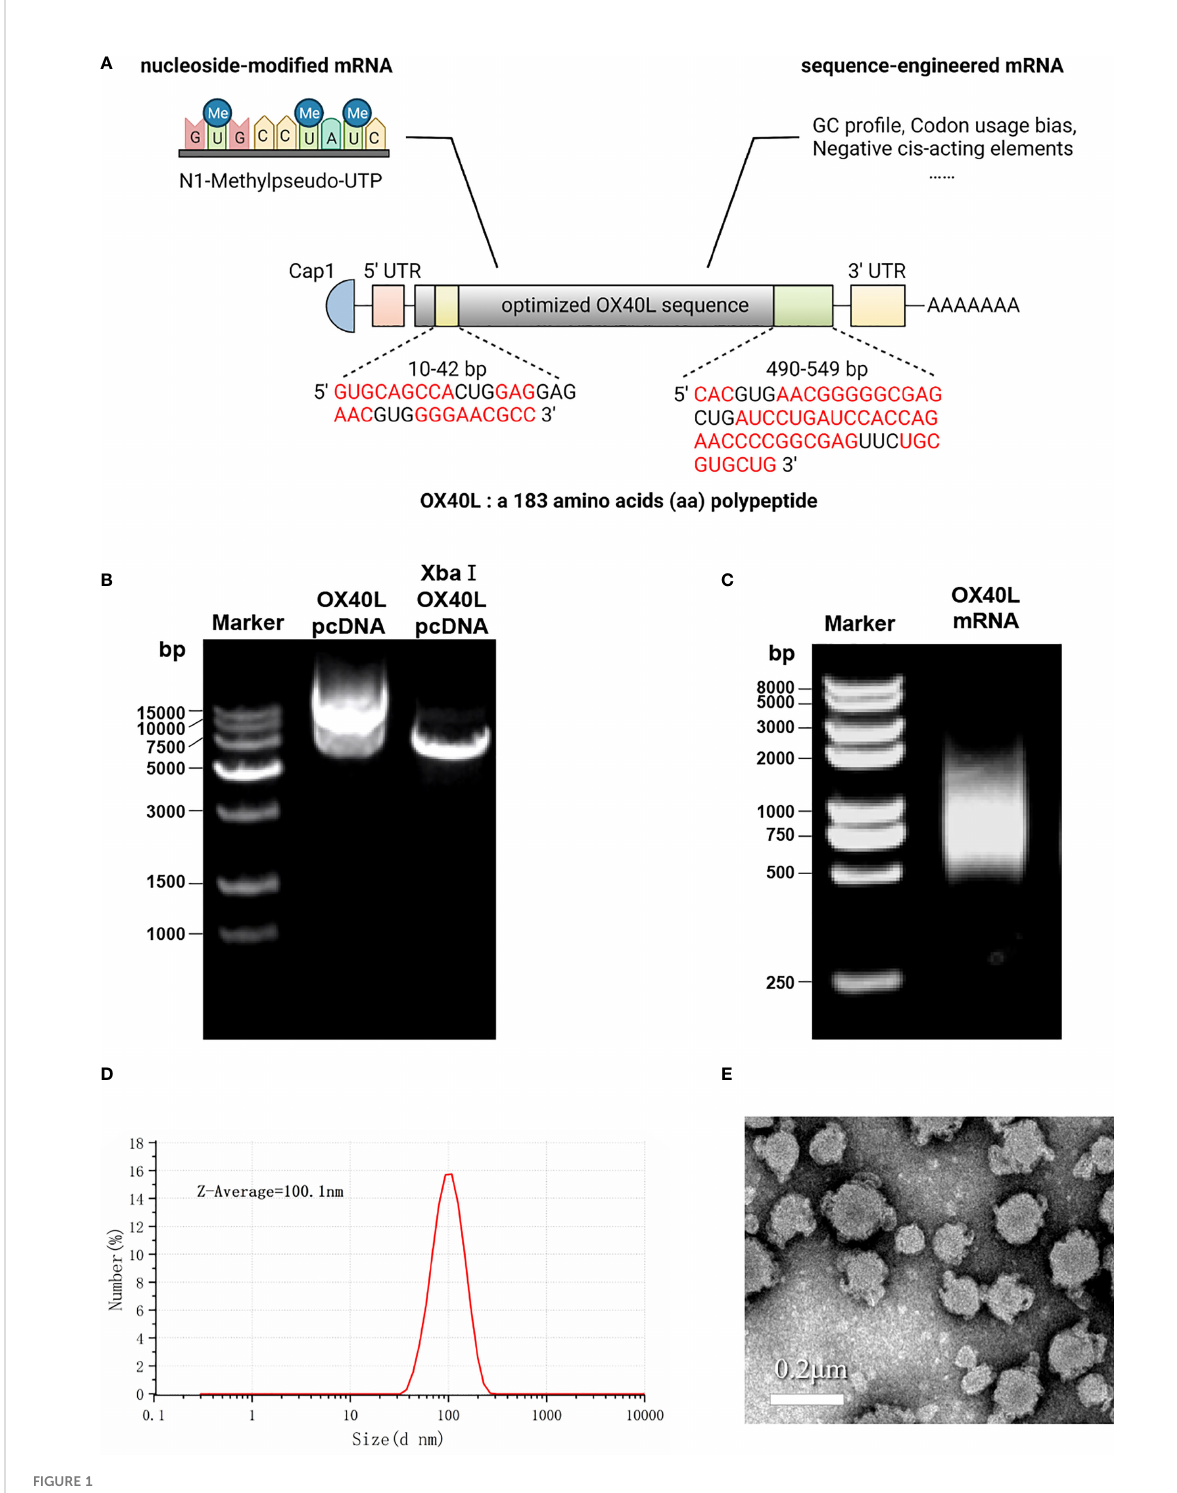
FIGURE 1 Optimization and characterization of encapsulated OX40L mRNA. (A) Structure of the optimized mRNA. Codons in red are optimized. (B) Identi fi cation of recombinant plasmid and restriction-digested plasmid by gel electrophoresis 1) 15000 bp marker, 2) 600 ng OX40L- pcDNA3.1 and 3) 200 ng Xba I -digested OX40L-pcDNA3.1. (C) Electrophoretic pro fi le of mRNA 4) 2000 bp marker; 5) 2 ug OX40L-mRNA. (D) Size distribution of OX40L mRNA-LNP. (E) TEM image of OX40L mRNA-LNP (scale bar: 200